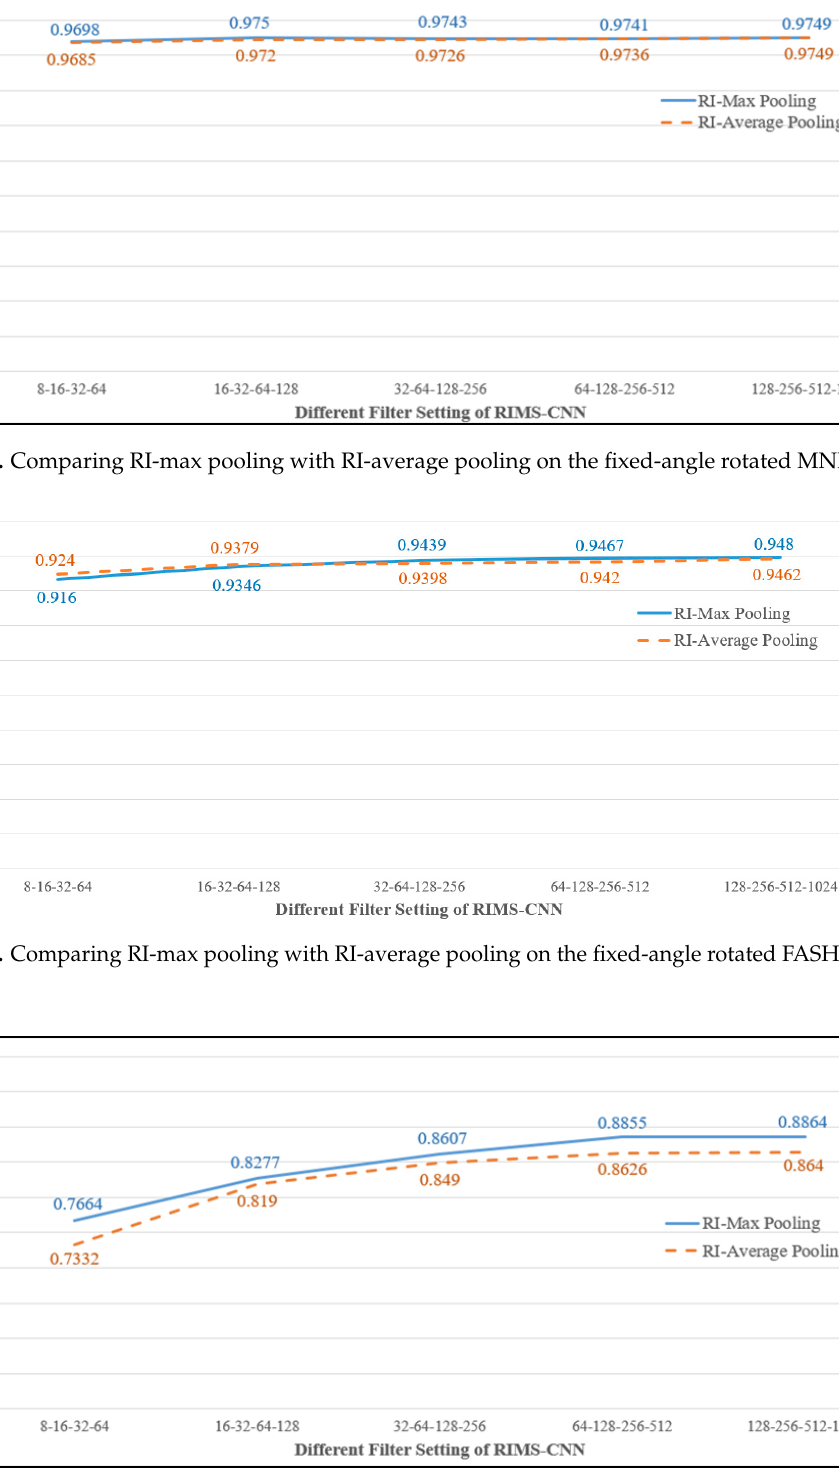
Figure 18. Comparing RI-max pooling with RI-average pooling on the fixed-angle rotated CIFAR-10.